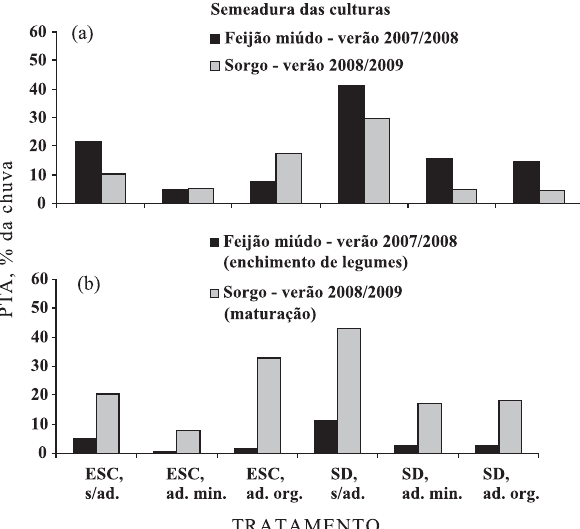
Figura 3. Perda total de água (PTA) nos testes de erosão realizados logo após a semeadura das culturas (a) e no estádio fenológico de enchimento de legumes do feijão-miúdo e no de maturação do sorgo (b), nos tratamentos estudados.